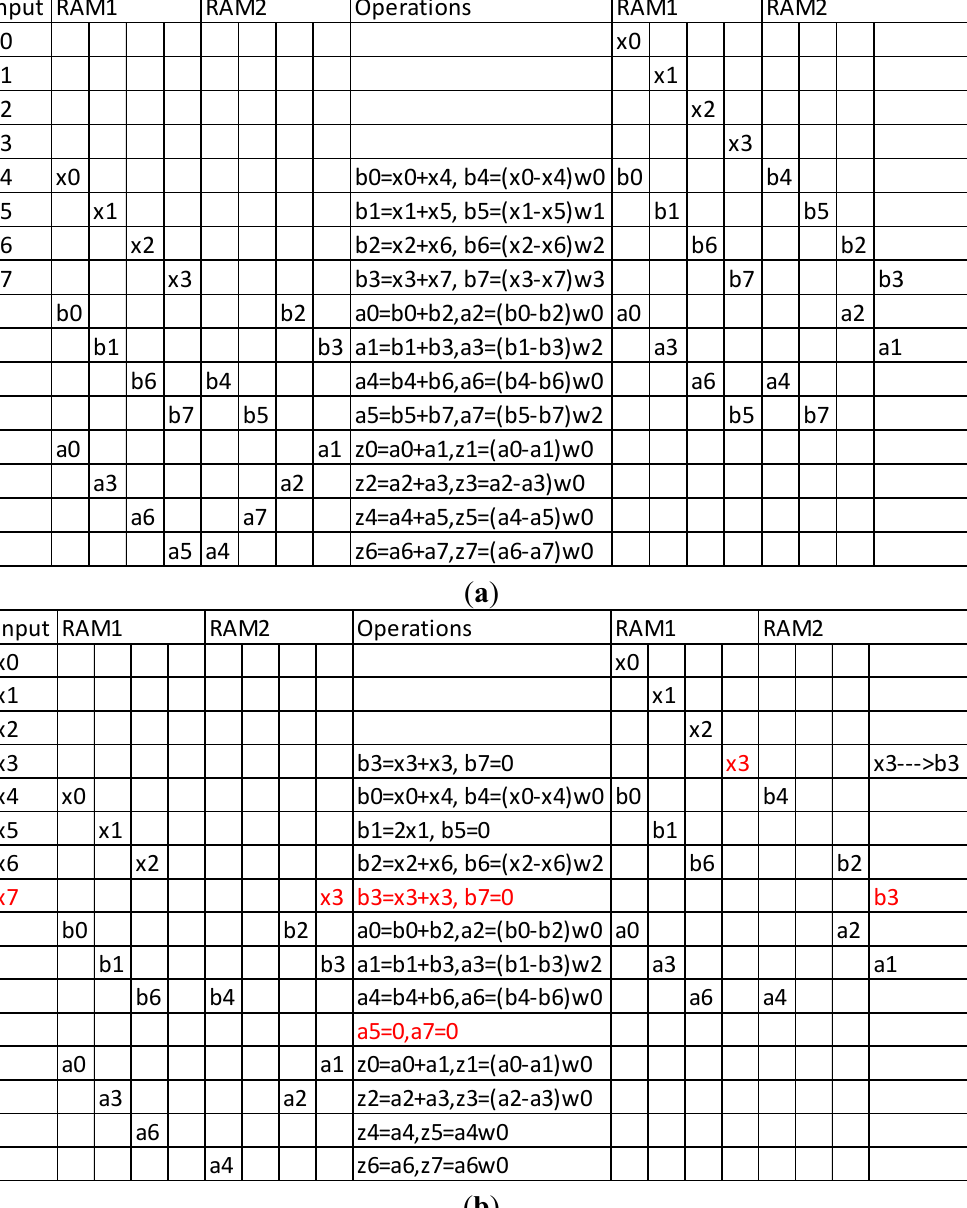
Figure 5. Original FFT implementation of [22] ( a ) and Modified FFT implementation for the proposed undersampling method ( b ). The operations with the red font in Figure 5b indicate trivial operations that can be